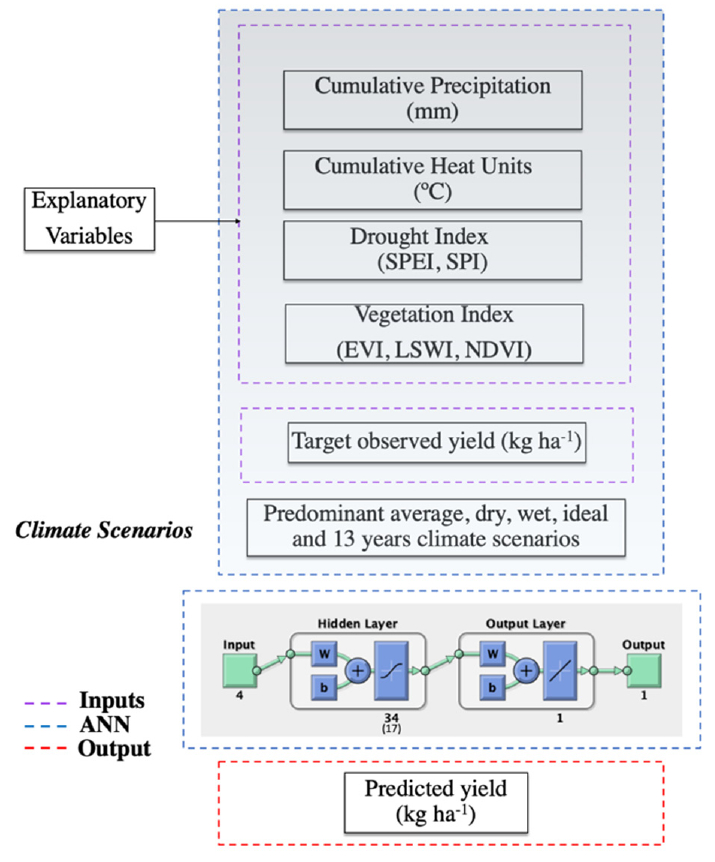
Figure 2. General workflow for cotton yield prediction using ANN.